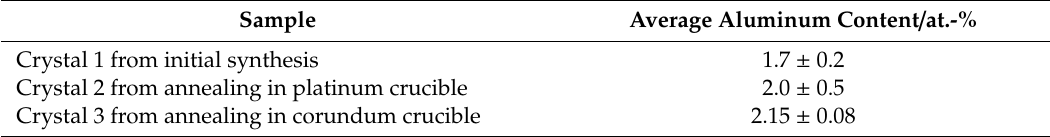
Table 5. Average aluminum contents of samples from the initial synthesis and annealed samples in at.-%. Shown errors represent the highest discrepancy between a single value and the